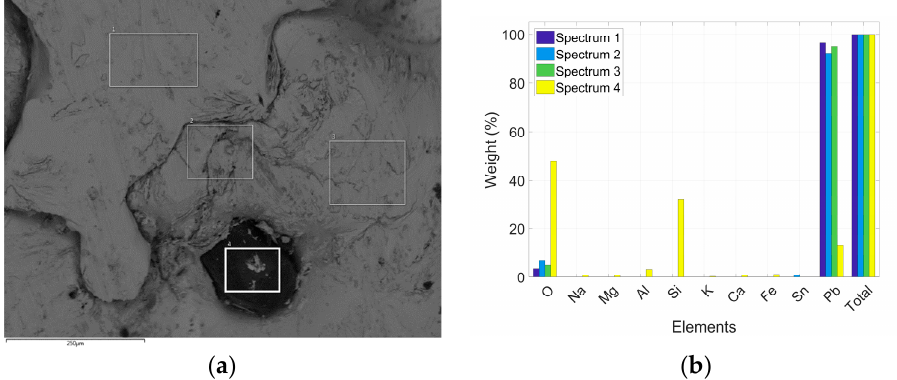
Figure 5. ( a ) SEM Image of sand inclusion at magnification 150× and ( b ) spectral analysis of the corresponding regions (1–4).